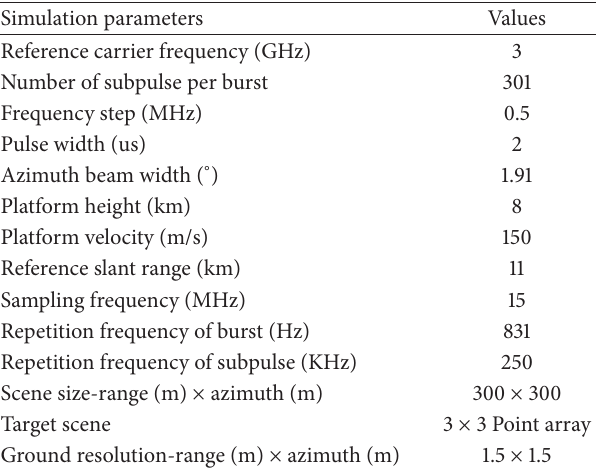
Table 1: Simulation